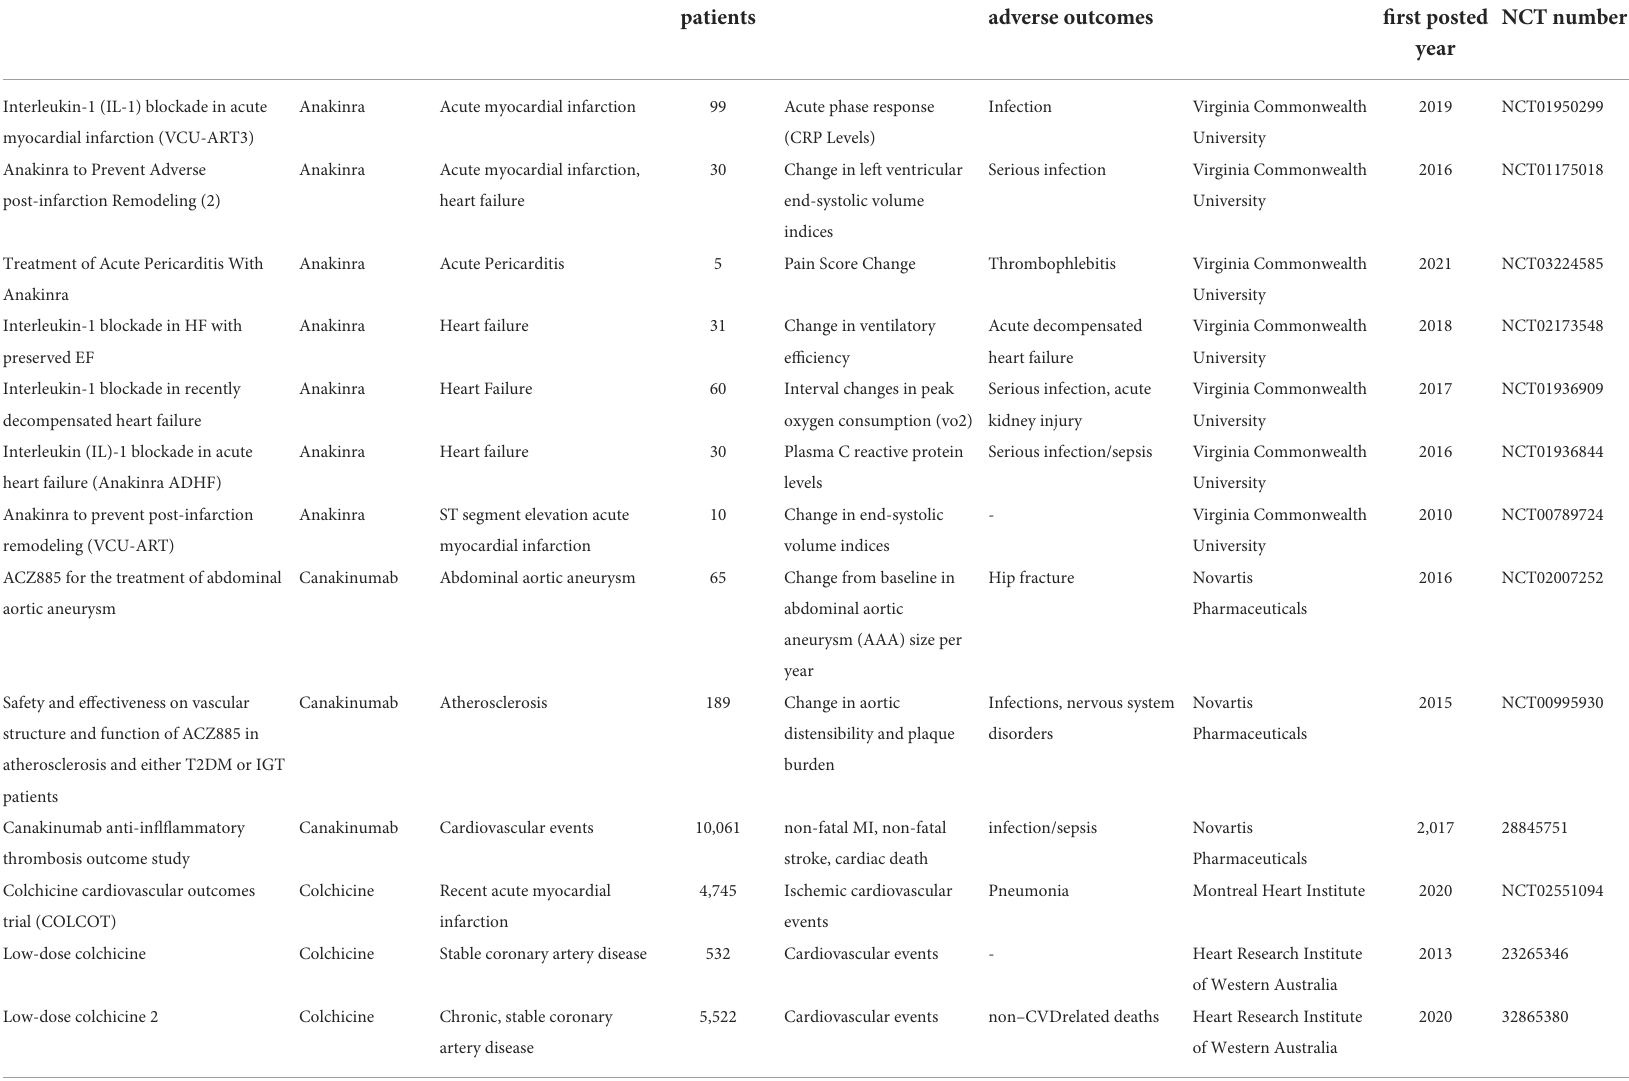
TABLE 1 Overview of completed clinical trials and major